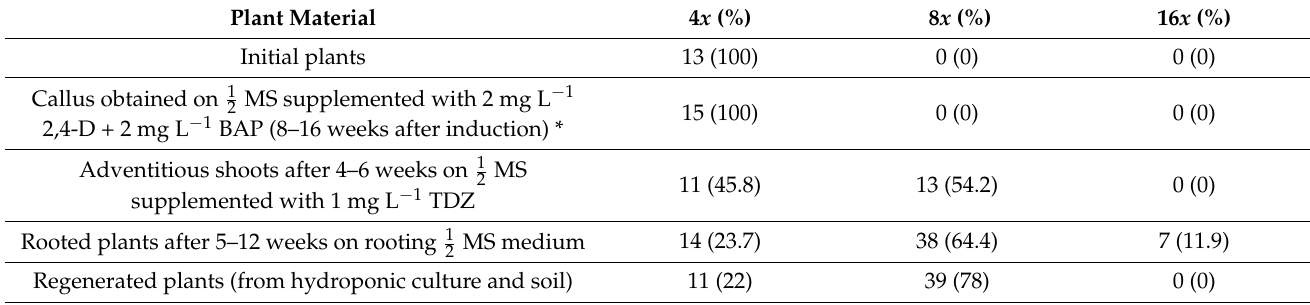
Table 2. Number and frequency (%) of 4 x , 8 x , and 16 x at different stages of Arabidopsis arenosa